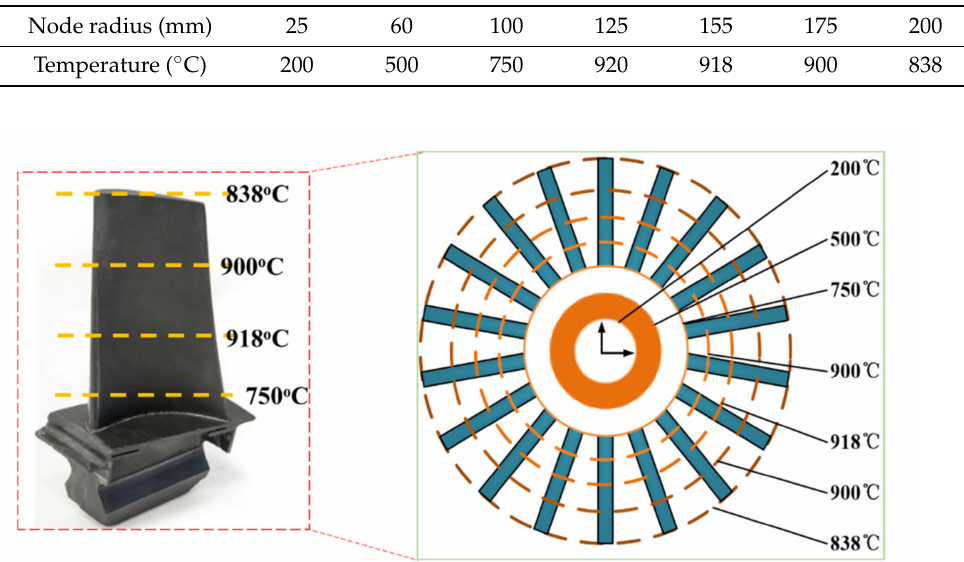
Table 2. Temperature interpolation data at key locations.